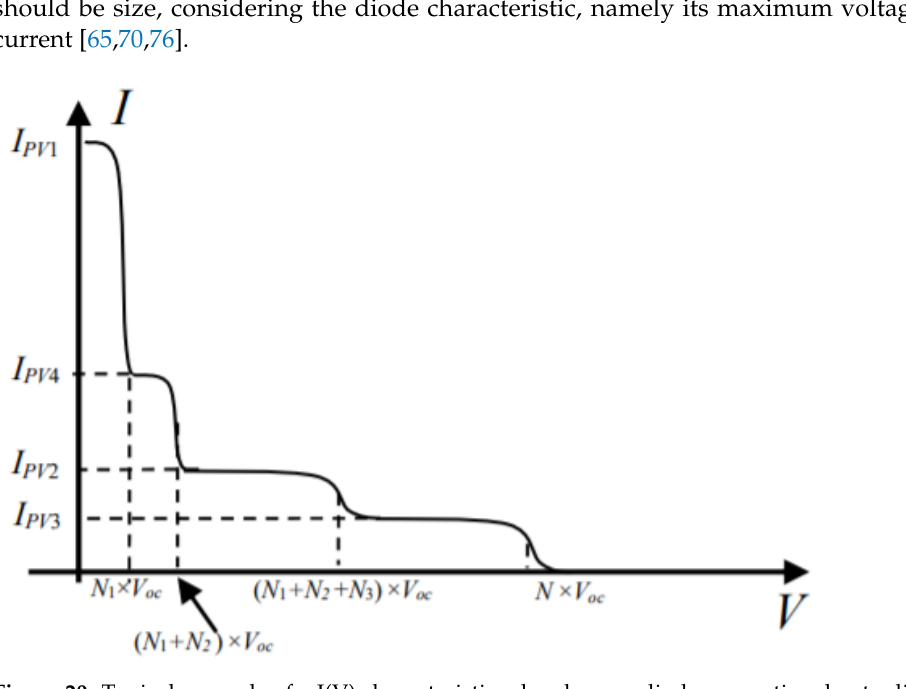
Figure 20. Typical example of a I(V) characteristic when bypass diodes are active due to different shading levels on a photovoltaic